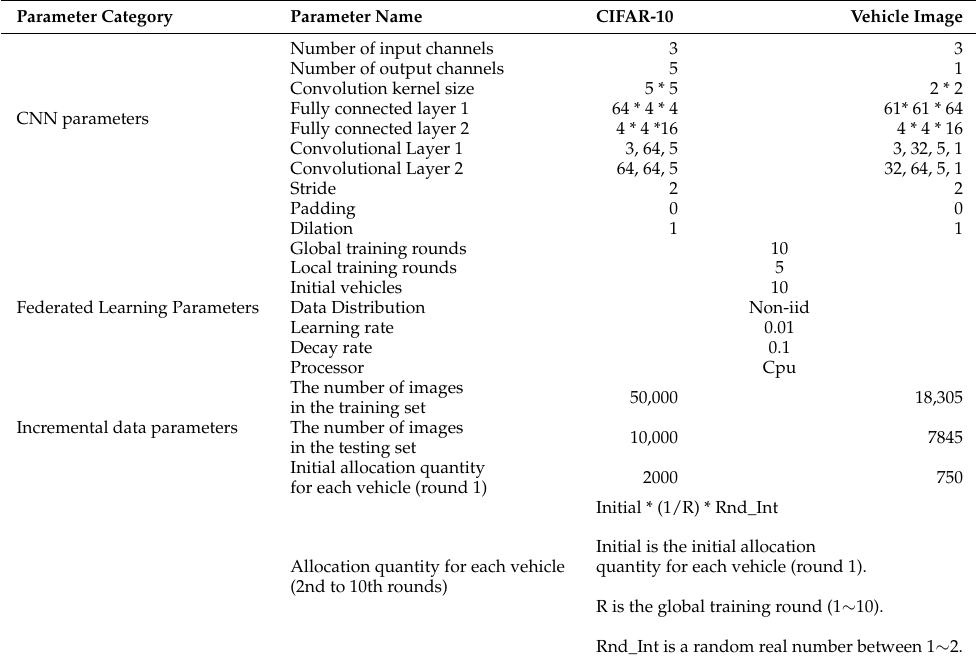
Table 3. Each specific parameter of the